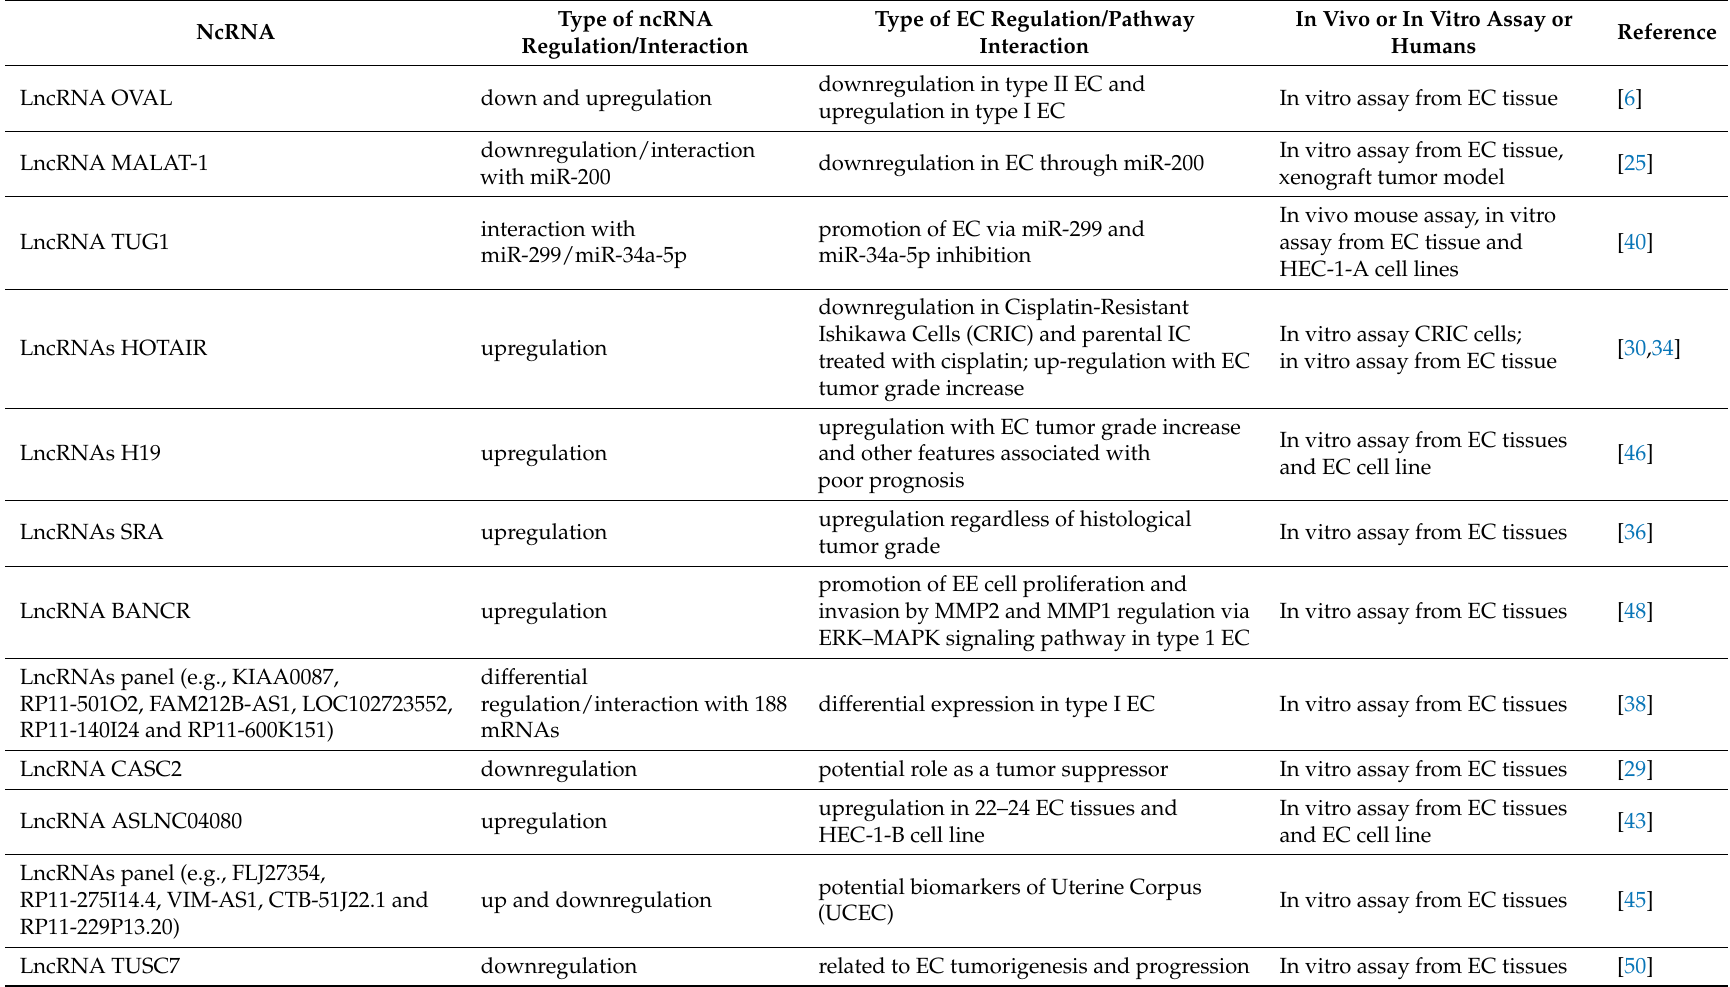
Table 1. Non-coding RNA expression and